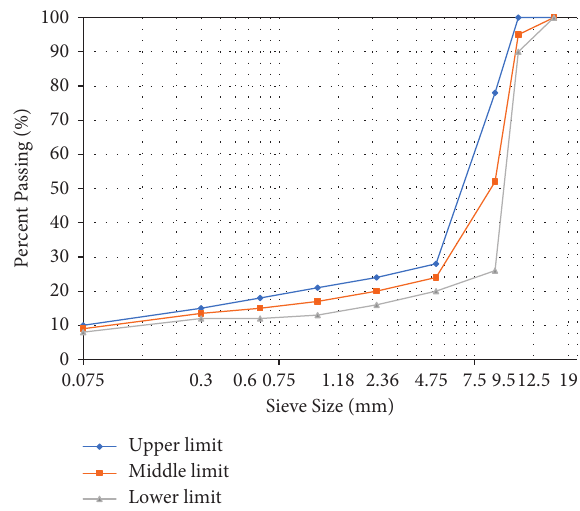
Figure 2: Aggregate gradation with NMAS of 12.5